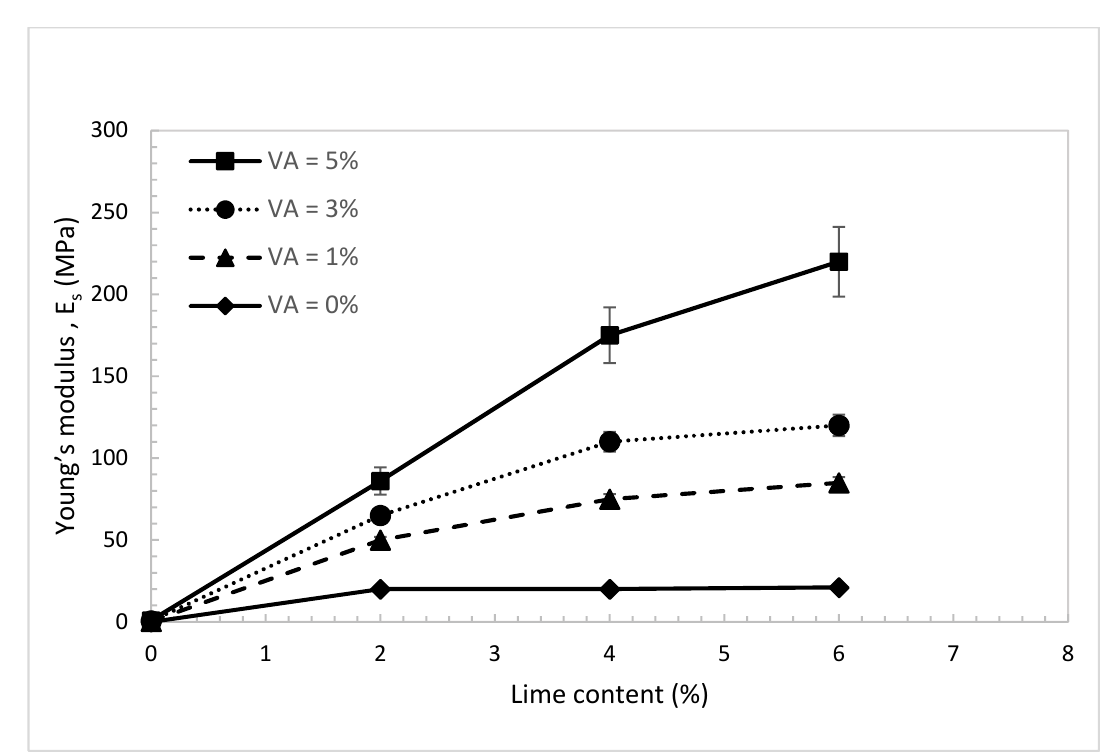
Figure 13. Young’s modulus of the treated dune sand vs. lime content for different percentages of volcanic ash. Coefficients of variance calculated for lime and volcanic ash treatments, using the 9 test samples, on the Young’s modulus response are 5.1 and 6.0, respectively. The statistical analyses show that the calculated P lime and P VA values for the modulus are 0.0168 and 0.0068, respectively. Although the P lime value is smaller but still comparable to the order of the statistical significance, implying a weak dependence of the modulus on lime